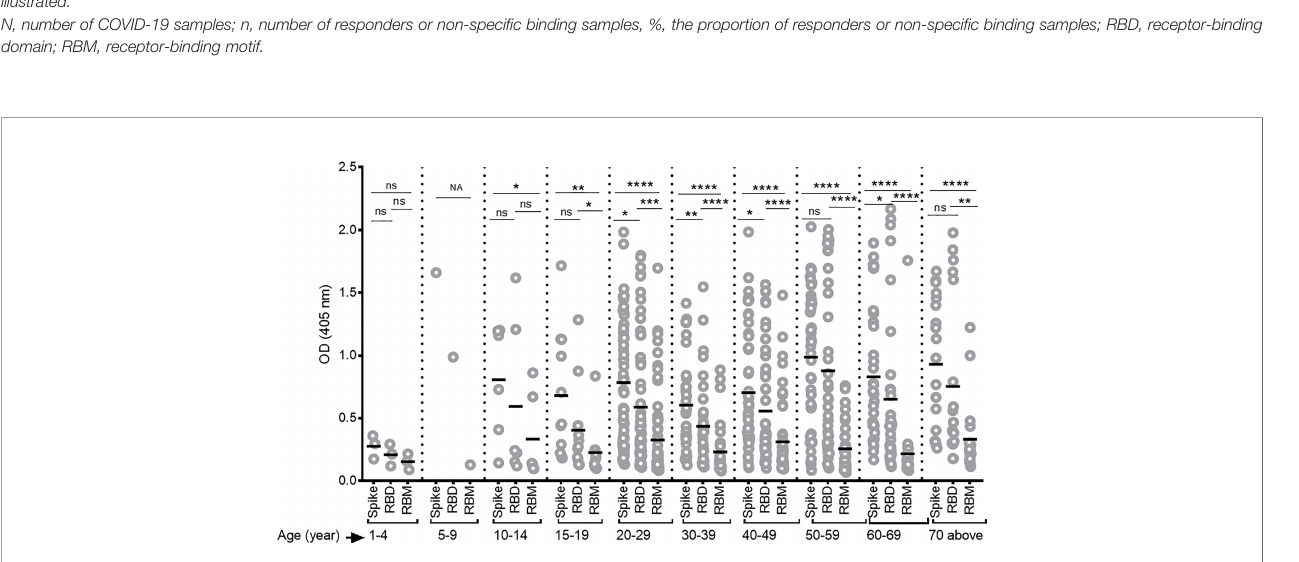
The proportion of samples showing non-speci fi c binding antibodies for S, RBD, and RBM was determined in COVID-19 patient samples. The non-speci fi c binding antibody samples are those showing in no antigen-coating, i.e., in plates coated with no antigen, a mean OD of antibody ≥ mean OD in antigen coating. The median OD and interquartile (Q1 and Q3)